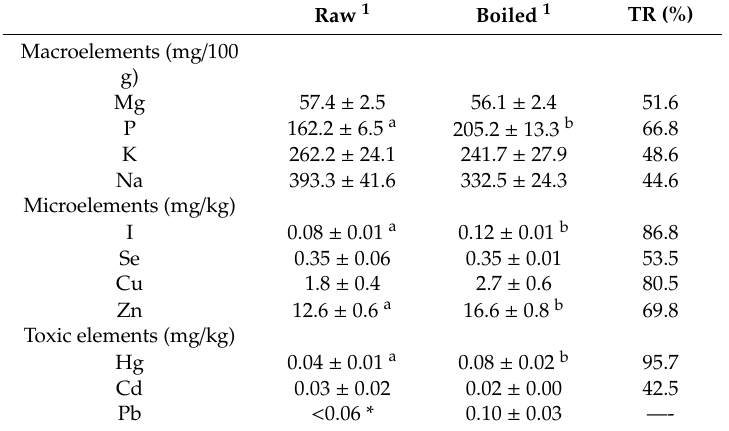
Table 6. Concentration of macro, micro, and toxic elements and true retention (TR) of common octopus.